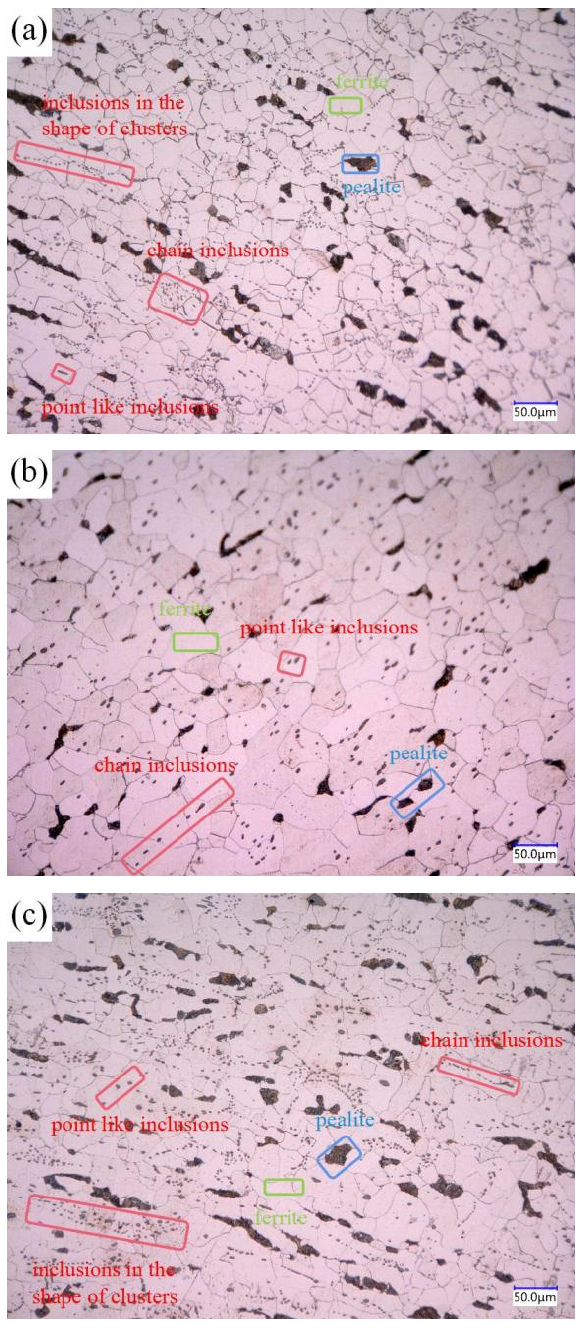
Figure 3. Metallographic pictures of 3 groups of steel: ( a ) 1#; ( b ) 2#; ( c )